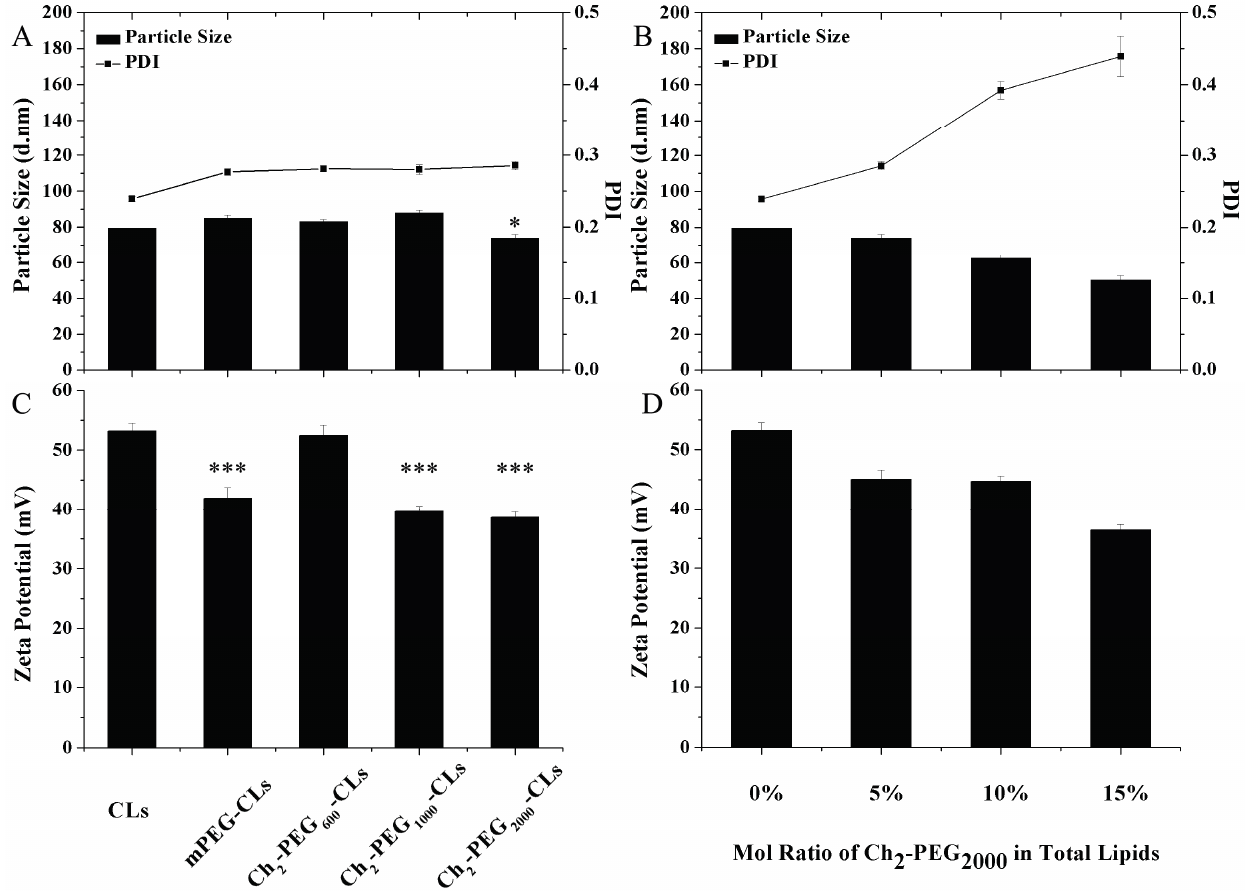
Figure 2. Particle size, PDI and zeta potential of Ch 2 -PEG n -CLs (Mean ± SD, n = 3, * p < 0.05, *** p < 0.001). ( A , C ) Particle size, PDI, and zeta potential of Ch 2 -PEG n -CLs, CLs (normal cationic liposomes without PEG introduction) and mPEG-CLs; ( B , D ) The effect of molar ratio of Ch 2 -PEG 2000 on the particle size, PDI and zeta potential of Ch 2 -PEG 2000